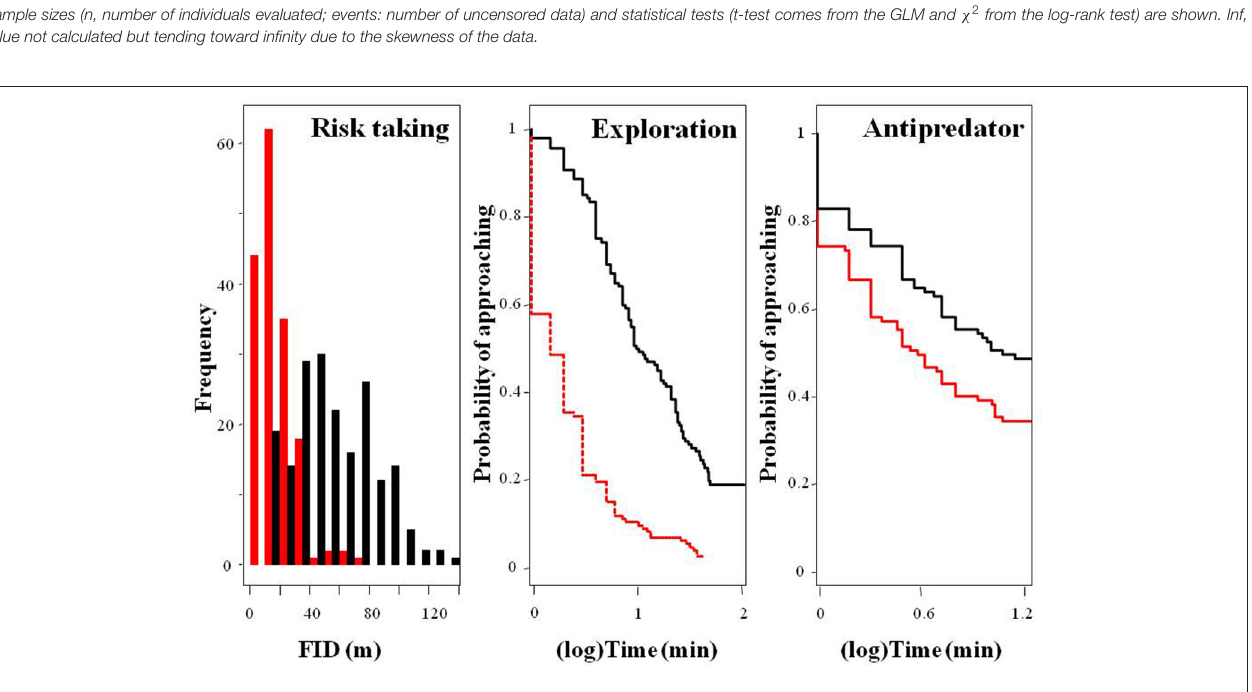
birds were more fearless in the face of humans and approached both the new food resource and the predator more quickly than their rural